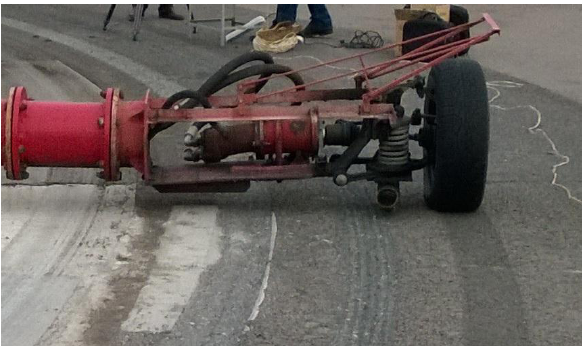
Figure 3. A part of an experimental track and test load